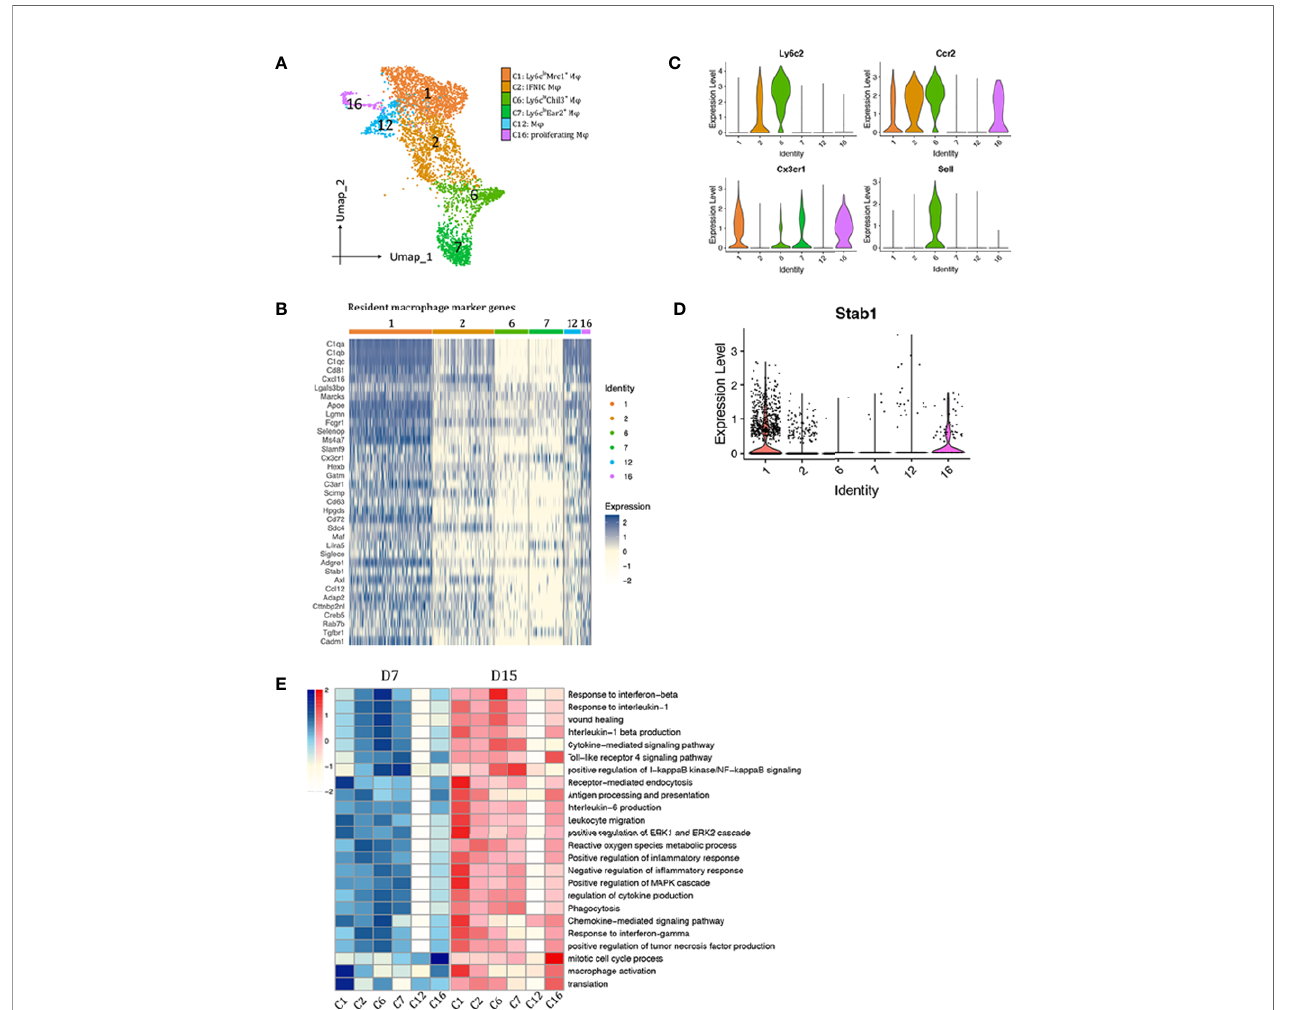
FIGURE 3 | Macrophages subtypes presented in the allografted kidneys. (A) Integrated UMAP projection of the six macrophage clusters identi fi ed in the kidney grafts (clusters 1, 2, 6, 7, 12 and 16), colored according to cluster designation. Cell identities are annotated on the right. (B) Heatmap showing normalized expression of resident macrophage marker genes in macrophage clusters. Expression levels from low to high are colored from white to blue. Average expression scale is shown on the right. Violin plot showing normalized expression levels of the (C) Ccr2, Sell, Cx3cr1 and Ly6c2 (D) Stab1 in macrophage clusters. (E) Heatmap showing scaled GSVA score of selected GO terms. Average expression scale is shown on the left. UMAP, Uniform Manifold Approximation and Projection; D7, day 7; D15, day 15; M j , macrophage; GO, gene ontology; GSVA, gene set variation